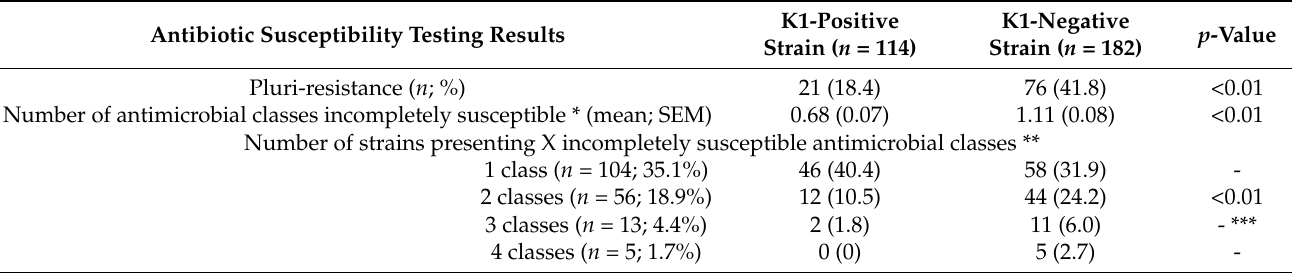
Table 3. Comparison of the AST multi-resistant